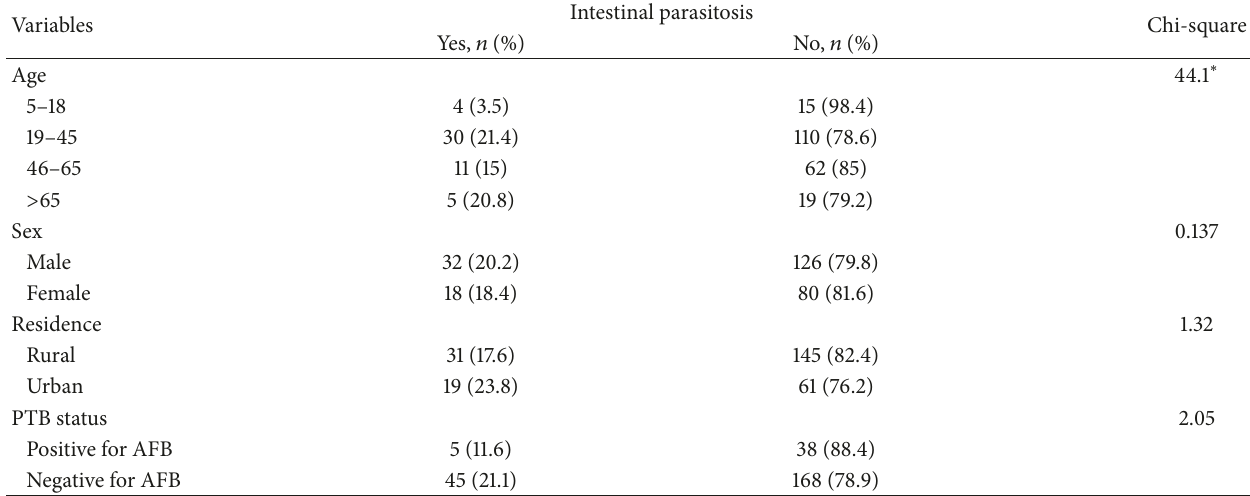
Table 4: Factors associated with intestinal parasites among PTB suspected patients at University of Gondar Hospital, Ethiopia, 2017.